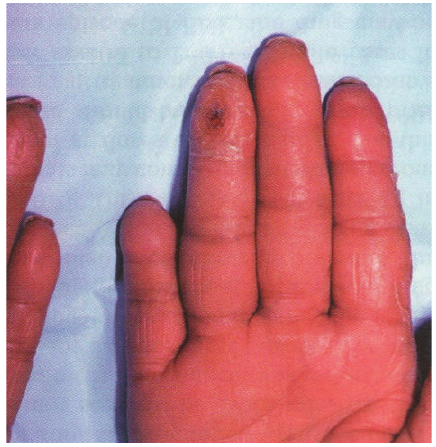
Figure 12: Leprosy—loss of tissue [4, page 351].